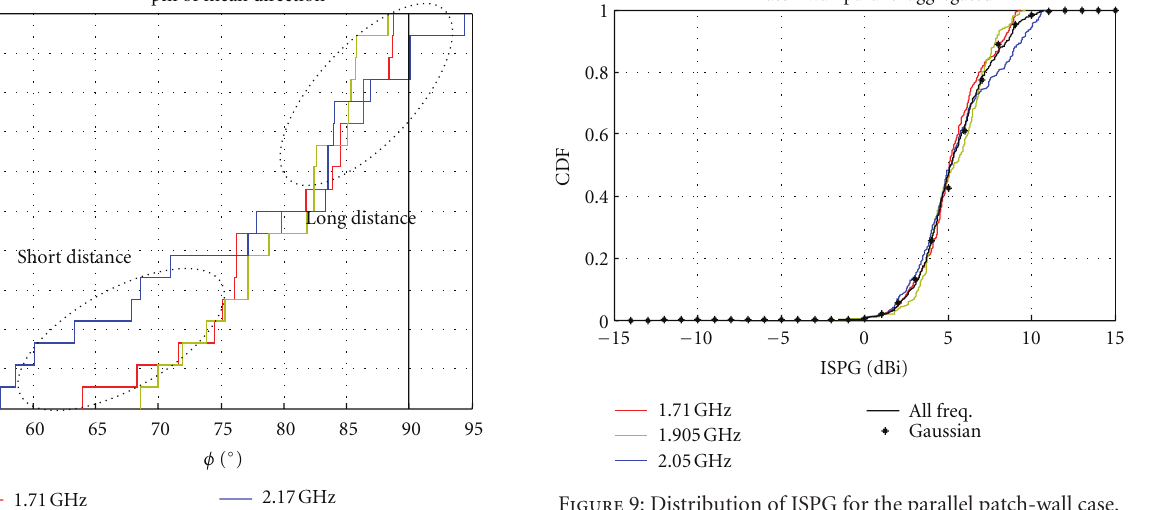
Figure 9: Distribution of ISPG for the parallel patch-wall case.